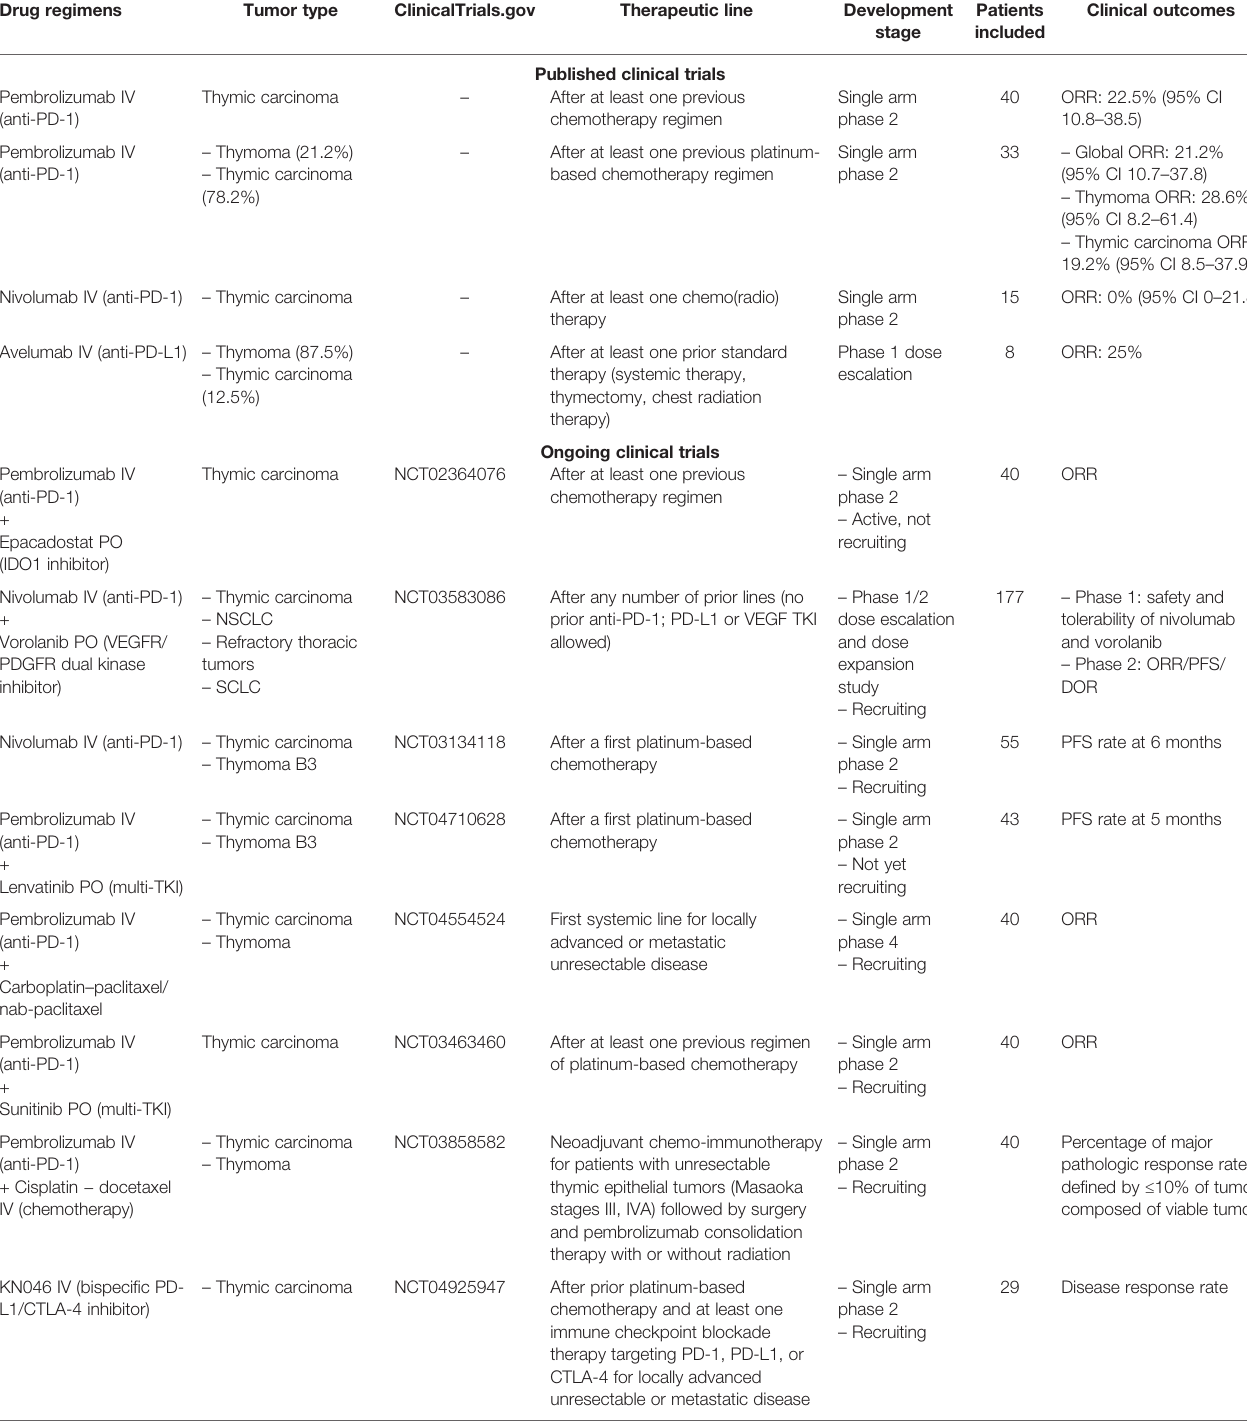
TABLE 1 | Completed and ongoing trials evaluating immunotherapy in thymic epithelial